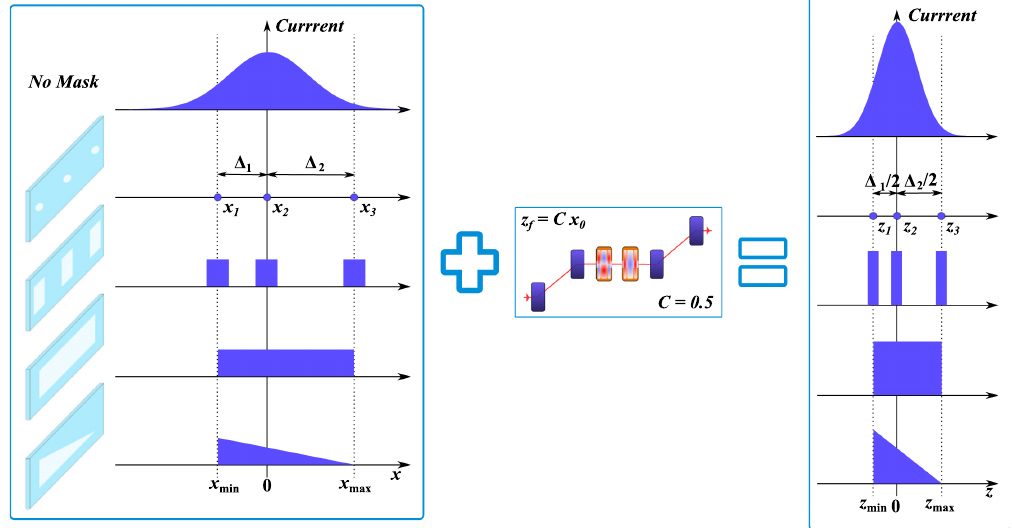
FIG. 2. The mask is used to produce the initial x-distribution after the mask (left) and the ideal EEX beam line linearly transforms this initial x-distribution to produce the final z-distribution (right). In the four examples shown, the coefficient ( C 0 ) in Eq. (8) x is equal to 0.5 (i.e. z f ¼ 0 . 5 x i ) so that the separation ( Δ ) between the particles (top) and beamlets (second from top) is reduced by a factor of 2 ( Δ = 2